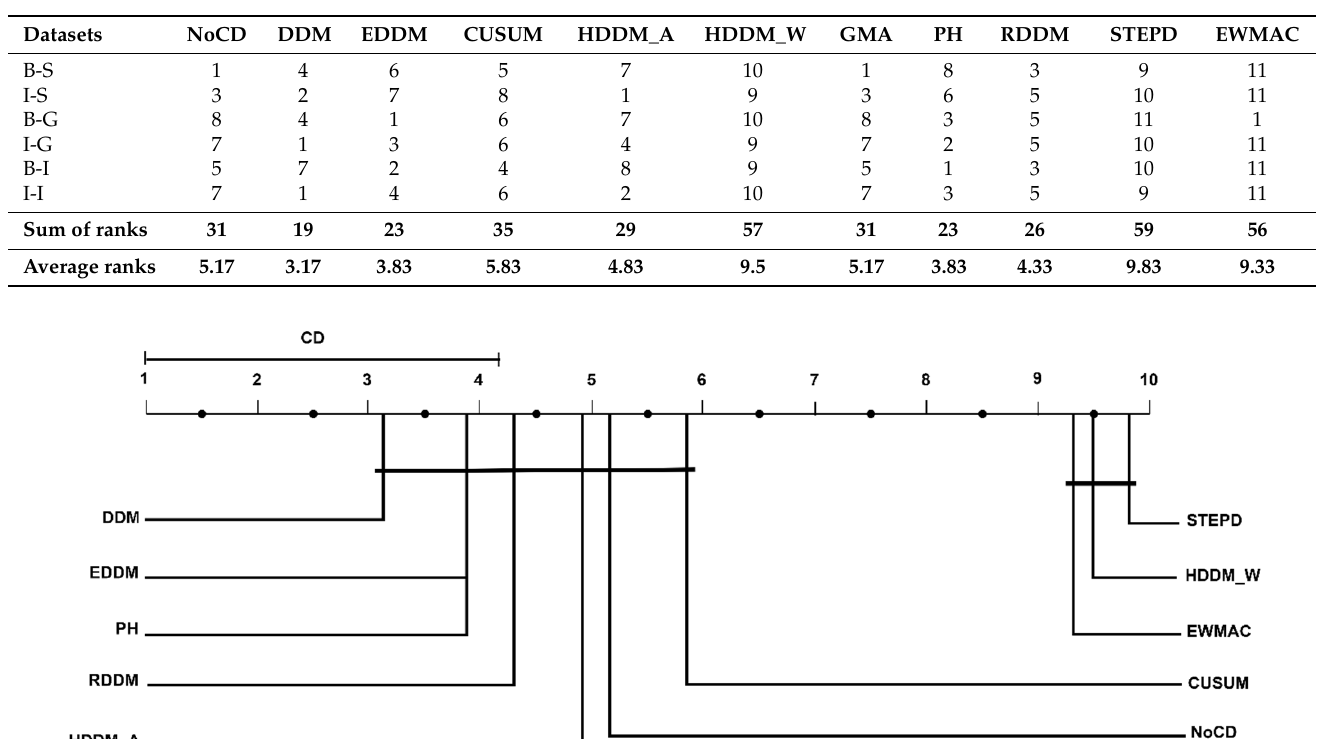
Table 6. Overall ranking of HT classifier with different drift detection methods.